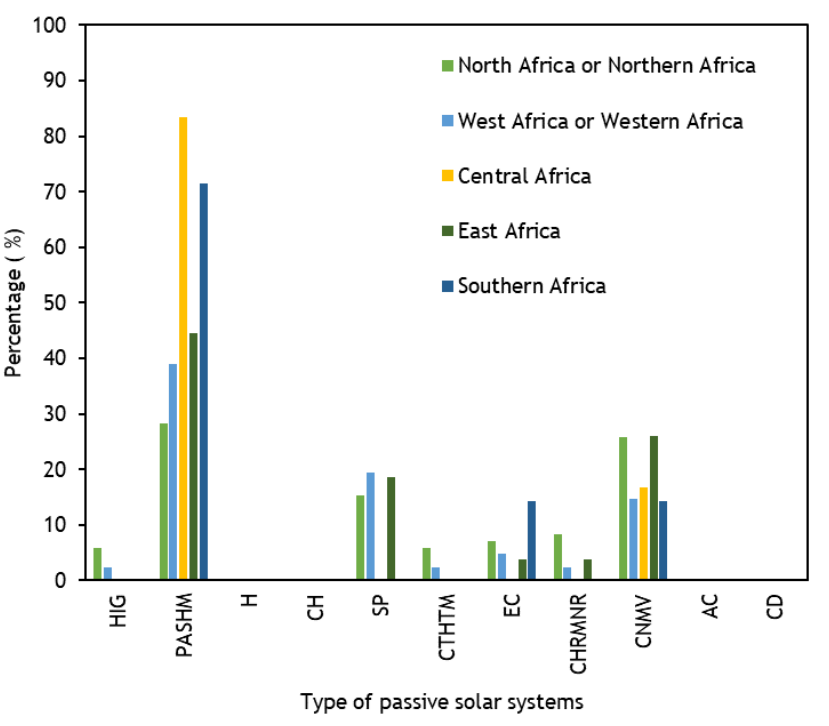
Figure 5. Identified solutions by region as a percentage. In which: HIG; PASHM; H; CH; SP; CTHTM; EC; CHRMNR; CNMV; AC; CD as mentioned in Appendix A, Table A2.